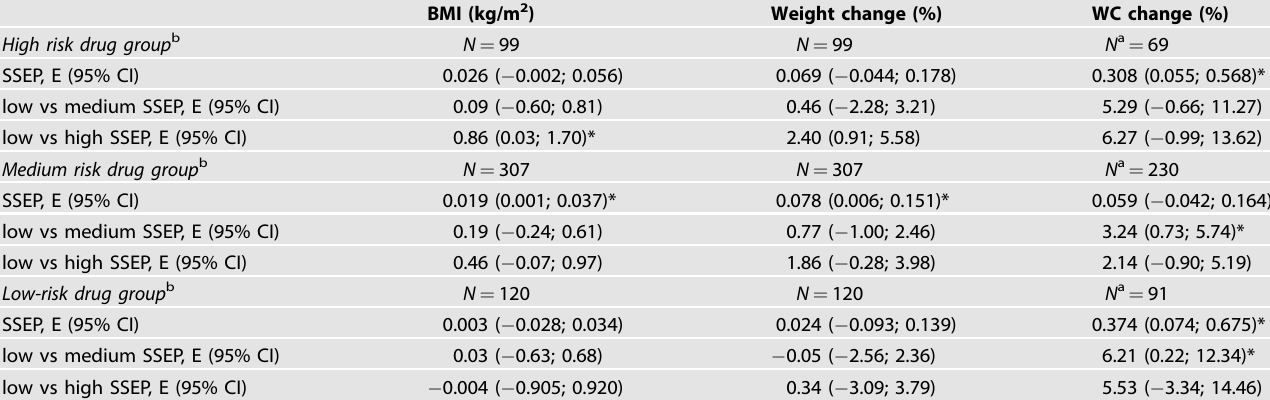
Table 3. Association between SSEP and BMI, weight change, and waist circumference change strati fi ed by psychotropic medication groups in the adult